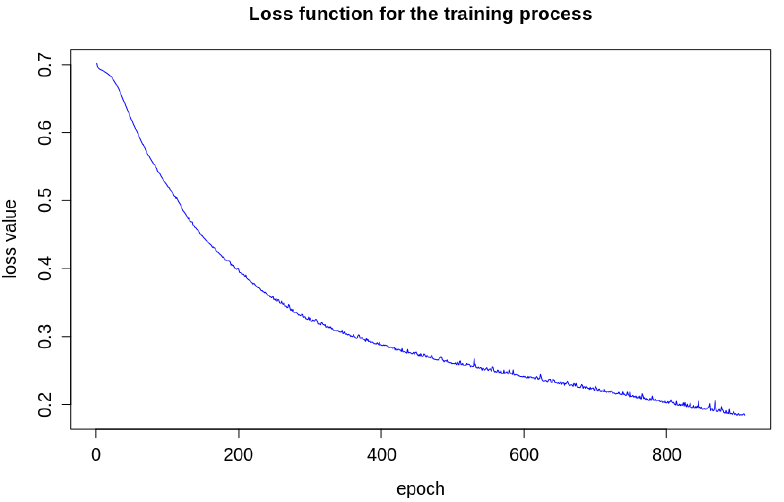
Figure 10. Neural network representation. The chosen model was a multi-layer perceptron (MLP). All layers are fully connected. The number beneath the blocks represents the number of neurons in each layer.